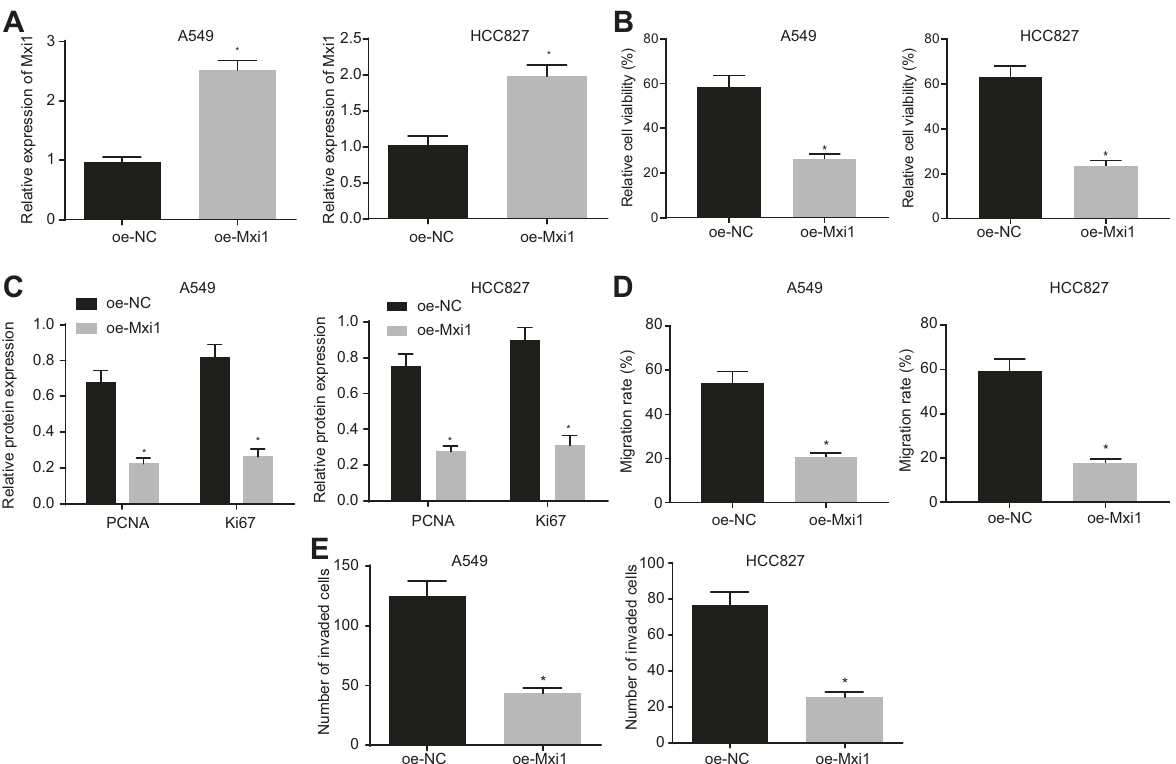
Fig. 2 Mxi1 elevation suppresses lung cancer cell proliferation, migration, and invasion. A Result of RT-qPCR detecting the mRNA level of Mxi1 in A549 and HCC827 cells. B Result of FACS detecting the cell viability of A549 and HCC827 cells with or without Mxi1 overexpression. C Representative images and quantitation of Western blot analysis detecting the protein expression of PCNA and Ki67 in A549 and HCC827 with or without Mxi1 overexpression. D Result of scratch assay evaluating the migratory potency of A549 cells and HCC827 cells with or without Mxi1 overexpression. E Transwell invasion assay detecting the invasion of A549 cells and HCC827 cells with or without Mxi1 overexpression. * p < 0.05, vs. oe-NC. Cell experiments were conducted three times